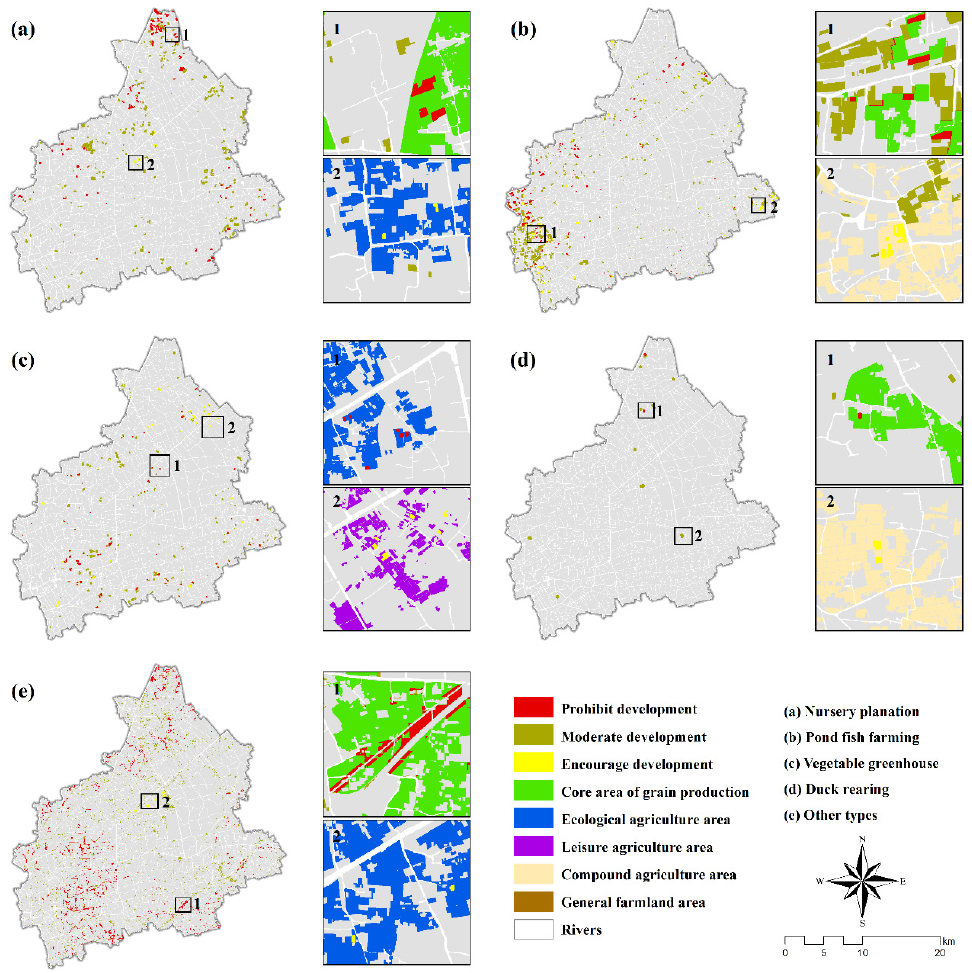
Figure 7. Spatial overlay between the current NGP distribution of Tongxiang city and multifunctional comprehensive zoning. ( a ). Nusery planation. ( b ). Pond fish farming. ( c ). Vegetable greenhouse. ( d ). duck rearing. ( e ). other types.